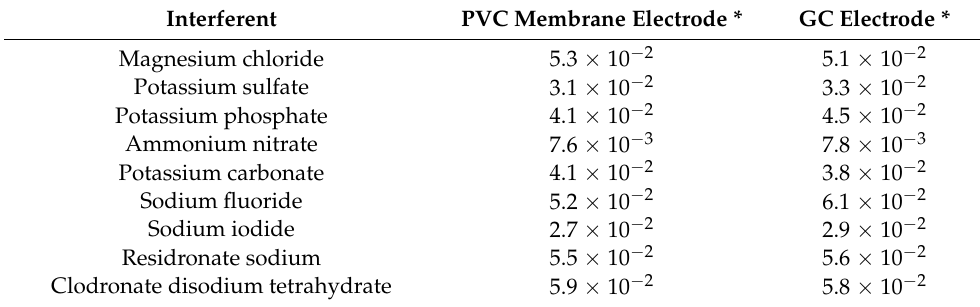
Table 4. Potentiometric selectivity coefficients of the proposed alendronate-selective sensors by matched potential method.